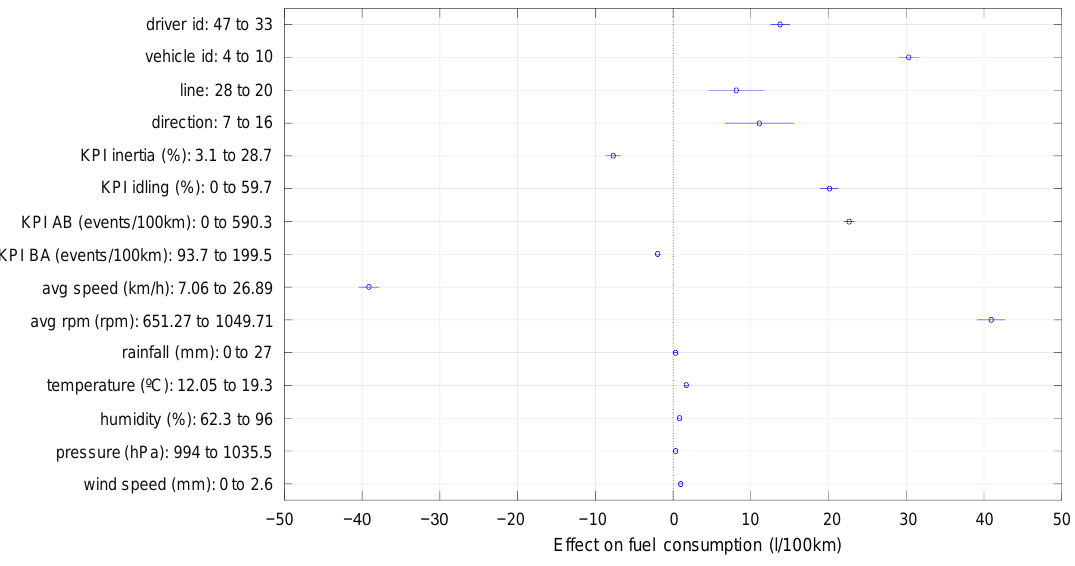
Figure 9. Effect of the predictors on fuel consumption.